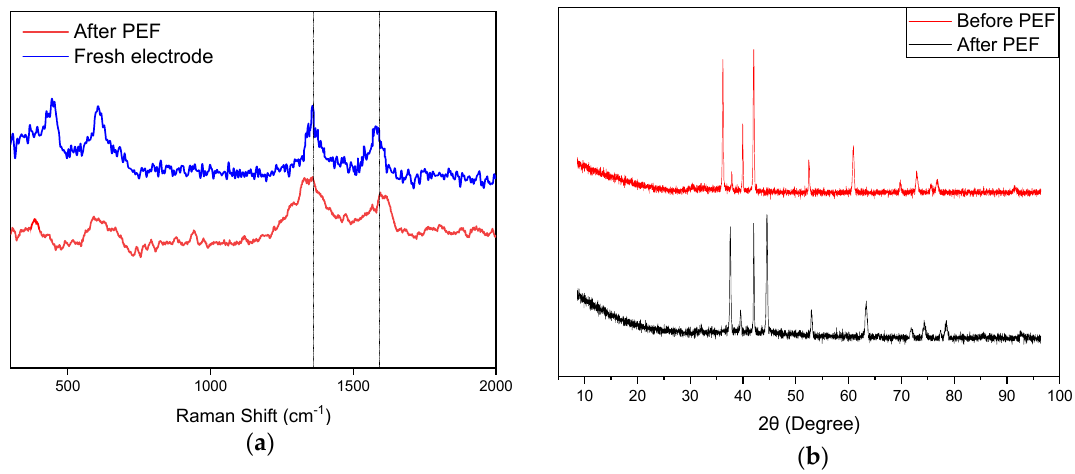
Figure 6. Comparative ( a ) RAMAN and ( b ) XRD spectra of fresh and used electrodes.